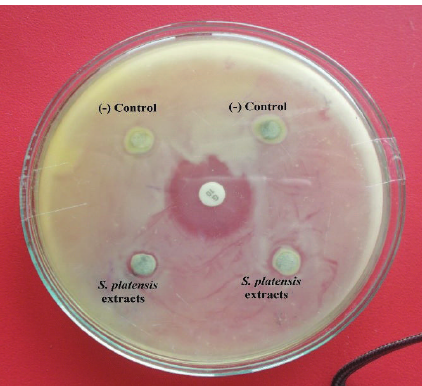
Figure 6: Antibacterial activities of gentamicin (+ control), de- ionised water ( − control), and S. platensis extracts against Proteus vulgaris